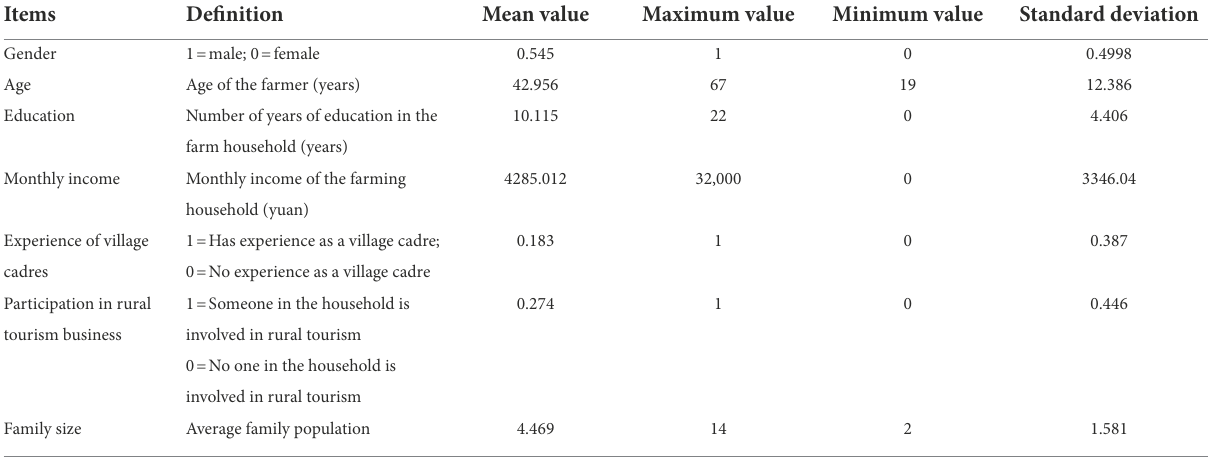
TABLE 1 Respondent’s profile ( N =